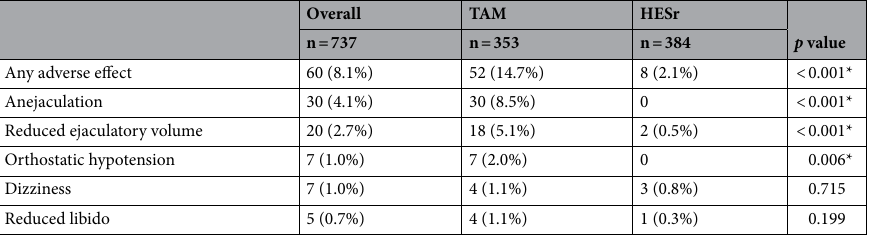
Table 5. Reported adverse effects for the study sample overall and by treatment group. Only AE with an incidence of ≥ 1% in any of the groups are reported (iterative matching sample). TAM: tamsulosin; HESr: hexanic extract of Serenoa repens. *Statistically